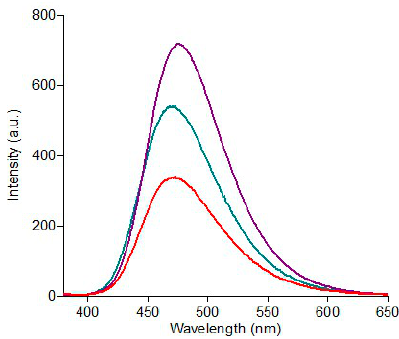
Figure 8. Emission spectra of Zn–Oligo–A (red), Zn–Oligo–B (green), and Zn–Oligo–C (purple) in DMSO (1 × 10 − 5 M, λ ex = 365 nm).